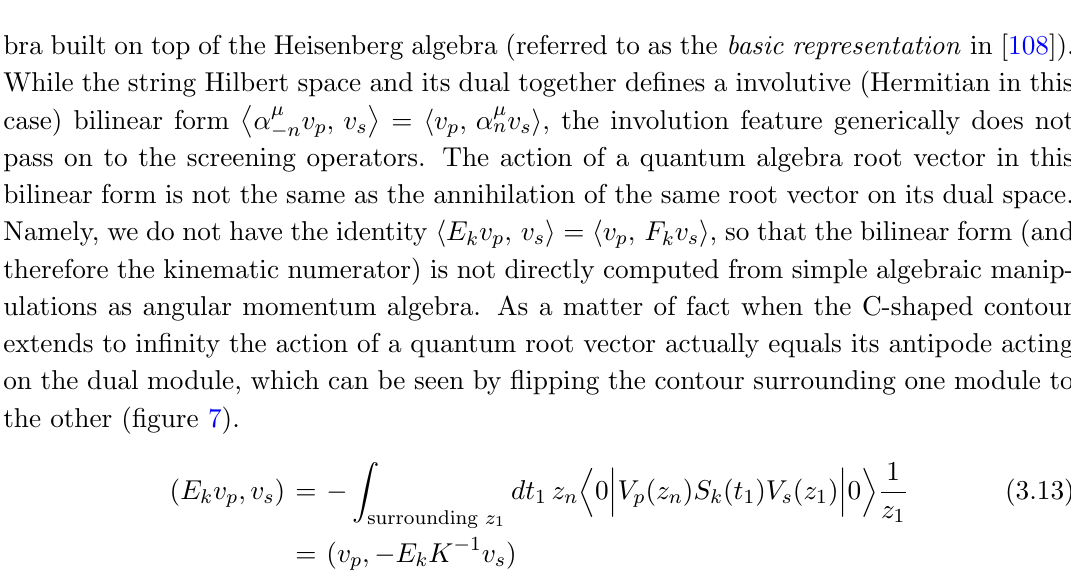
Figure 7 . Flipping the contour surrounding z n